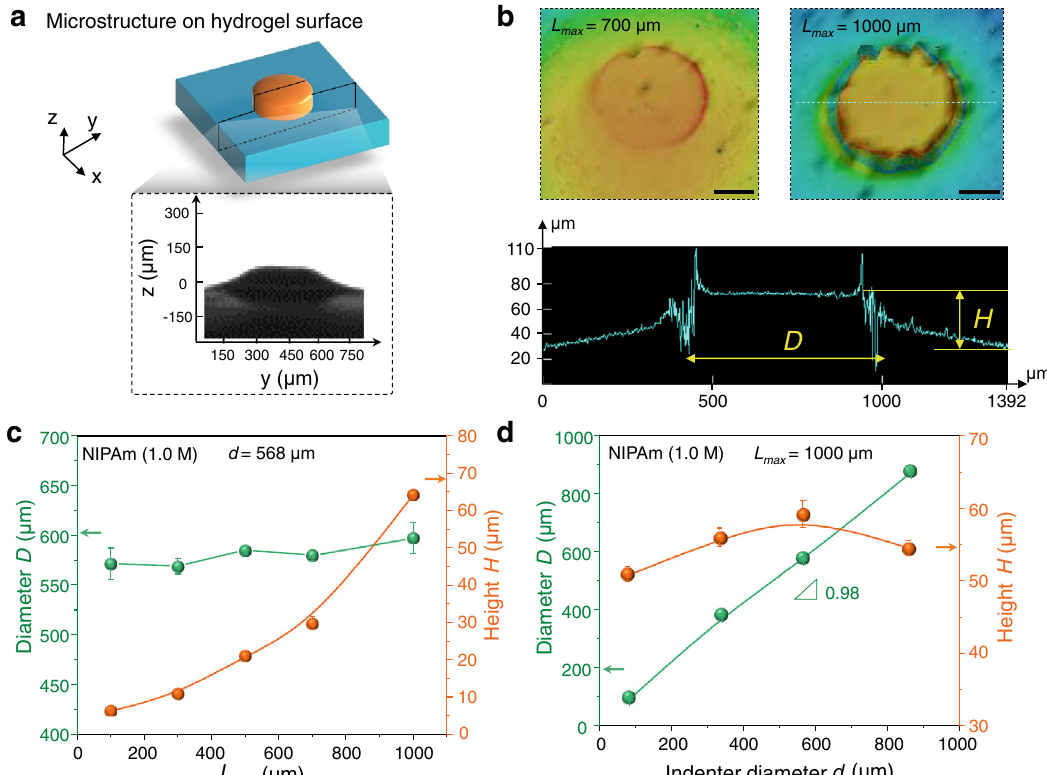
Fig. 2 | Indenter size and depth-controlled microstructure formation. a Schematic illustration and representative microscope image (side view) of the surface microstructure on DN hydrogel after indentation by a cylindrical micro- indenter. b Three-dimensional laser microscope images of the surface micro- structures obtained from different indentation depths L max by an indenter of dia- meter d =568 μ m, and the height pro fi le at the position shown by the dashed line. Scalebars,200 μ m. c Dependenceofthetopographicalheight H anddiameter D of